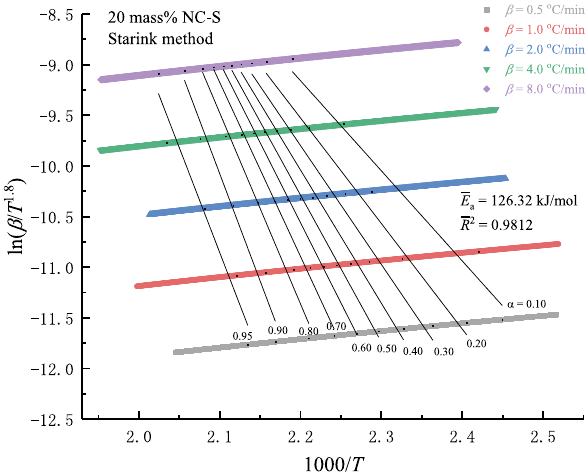
Figure 8. E a fitting curves by non-isothermal differential method for α from 0.10 to 0.95.